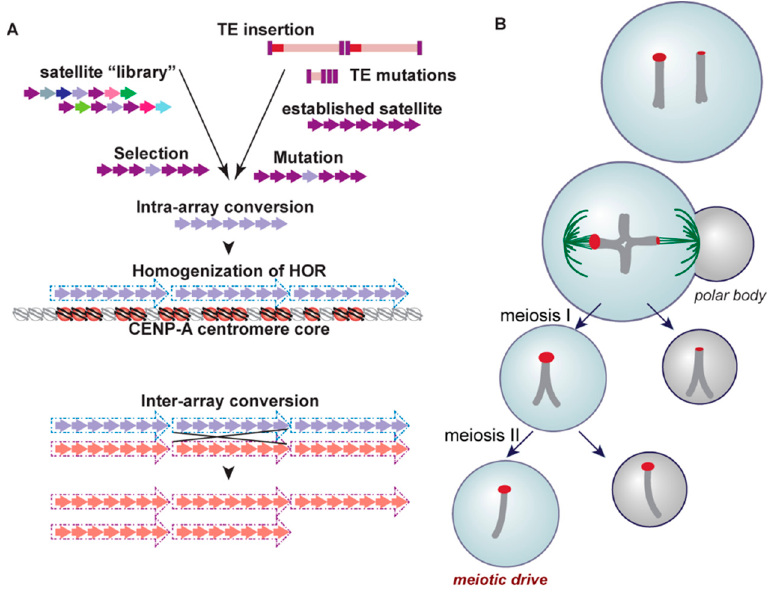
Figure 3. Schematic of the evolutionary mechanisms that impact centromere repeats. ( a ) Two models for the derivation of species-specific satellites are shown: (left) A satellite array evolves from a library of satellites, culminating in a dominant satellite; (right) TE insertion(s) followed by mutations, such as deletions, lead to the evolution of new satellites. In both cases, a homogenized array evolves through molecular drive mechanisms, such as intra-array concerted evolution. Stabilization of the arrays into HOR arrays defines the active centromere core, where CENP-A nucleosomes (red) are assembled. Other events, such as inter-array conversion, can lead to the spread of new HORs or changes in HOR copy number (bottom). ( b ) Two homologous chromosomes share the same satellite repeat (red), but one homolog experiences an expansion of that repeat through de novo mutations. During female meiosis, the larger centromere attracts more microtubules, resulting in the loss of the homolog with the weaker centromere into the polar body during meiosis I. The larger centromere is preferentially driven to the viable egg following unequal distribution of chromatids during meiosis II.